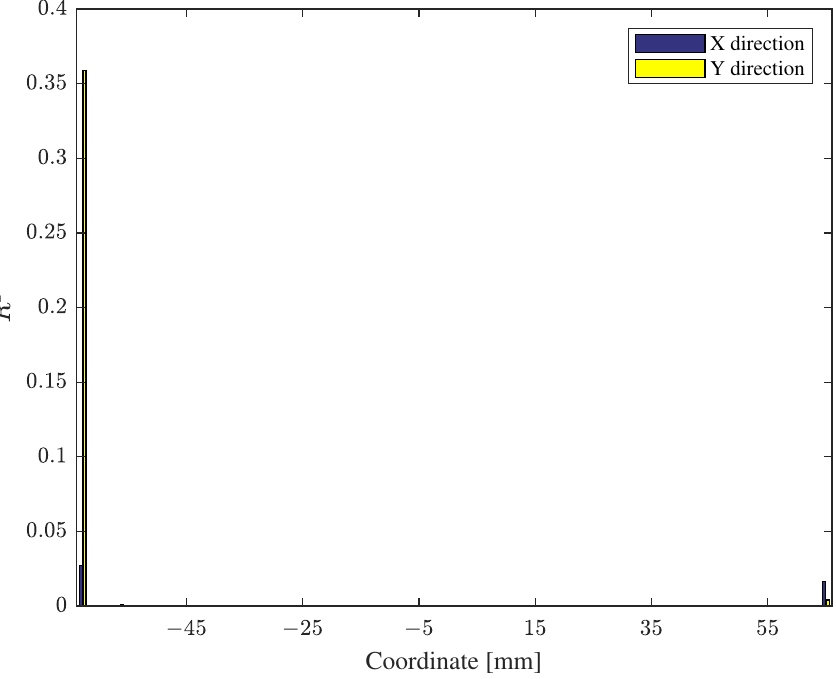
Figure 13. R 2 values of the predicted EMF simulation output measured across coordinates in X and Y directions with the testing